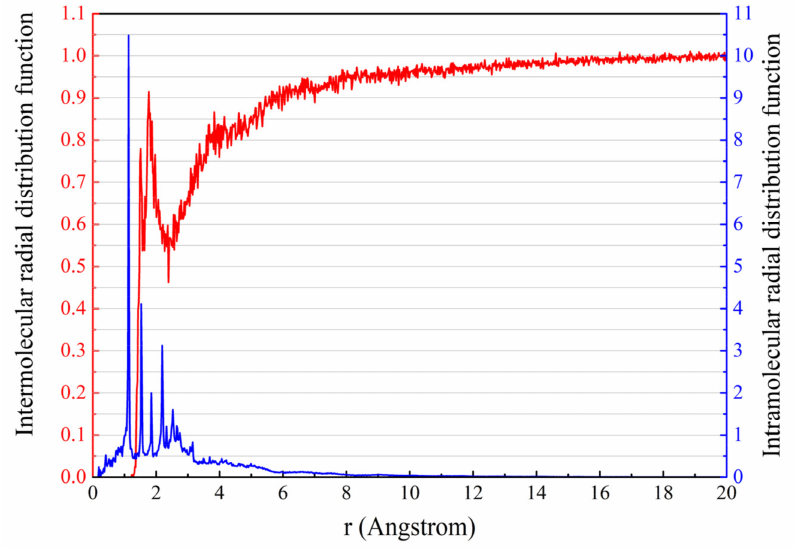
Figure 7. Results of the radial distribution function of the virgin asphalt model. In addition, the glass transition temperatures of three asphalt models were calculated in this study to further validate the reasonableness of the models. A linear plot of the specific volume of different asphalt models versus different temperatures (150, 200, 225, 250, 275, 298, 325 and 350 K) was plotted, and the temperature corresponding to the abrupt change in slope was taken as the glass transition temperature of the model [25], and the results are shown in Figure 8. It can be seen that the density of the system gradually decreases with increasing temperature for virgin asphalt, RPE-modified asphalt and CNT-RPE-modified asphalt, a result that is consistent with the properties of asphalt materials [25]. In all the density time curves, the density remained essentially constant after 40 ps. In this study, the average density of the system was calculated by taking the density values between 70 and 100 ps and taking the inverse to obtain the specific volume of the system at different temperatures and fitting it linearly to finally obtain the glass transition temperature of different asphalt systems [38,39]. It can be seen that the coefficients of de-termination of the linear fits of specific volume and temperature are all greater than 0.96, which indicates that the linear relationship between temperature and specific volume is obvious, and the glass transition temperature of asphalt can be characterized at the change of